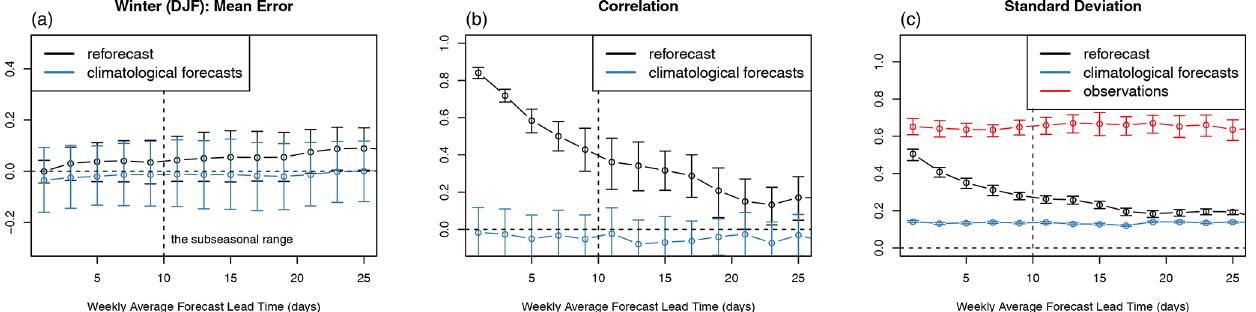
Figure 3. The verification measures of reforecasts (using the validation set, even winters 1996–2016) for the averaged area (Fig. 1). Refore- casts are the mean of one week of 6-hourly reforecasts and start every two days. For reforecasts and climatological forecasts, the parts of the MSE decomposition (Eq. 5) are: (a) the mean error, (b) correlation, and (c) standard deviation.